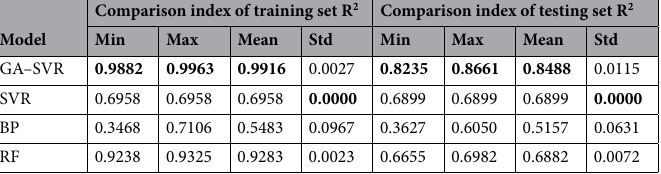
Table 2. Comparison index performance of R 2 . The optimal values of each evaluation index are in [bold].